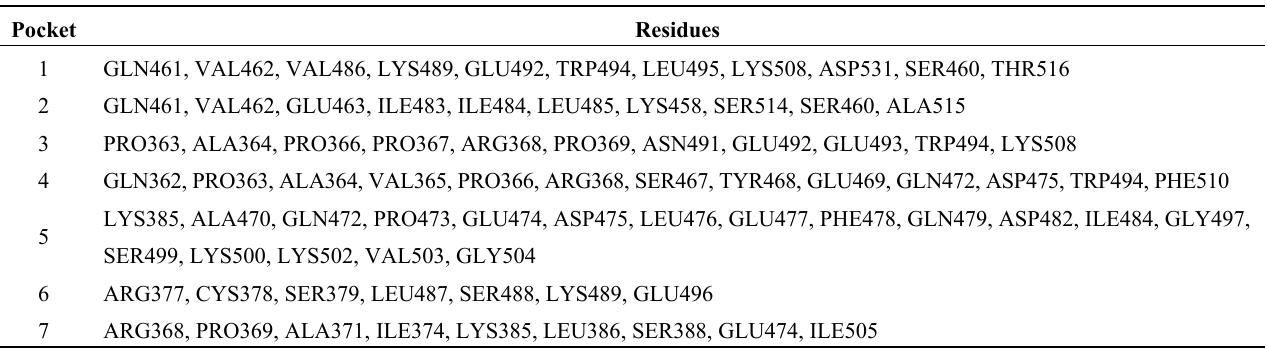
Table 1. The pockets in or on 1K4U identified by